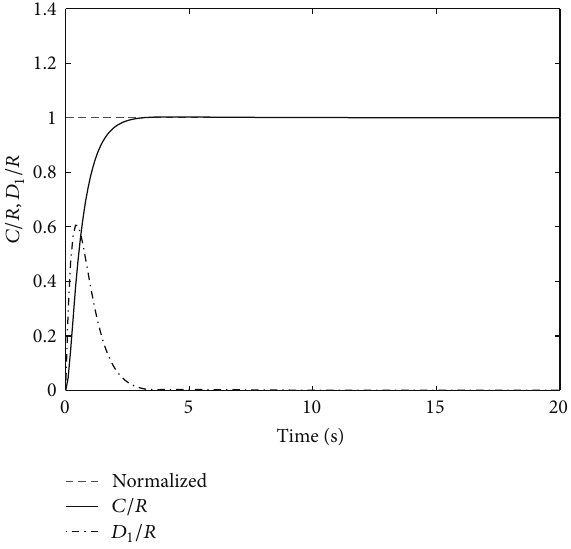
Figure6:Timeresponsesoftheillustratingexamplefor 𝑅 = 1, 5,10 , and 50.